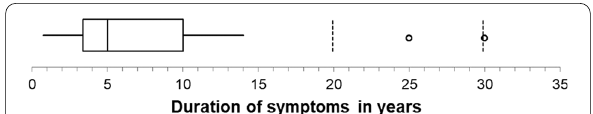
Fig. 1 Boxplot of duration of symptom in the study